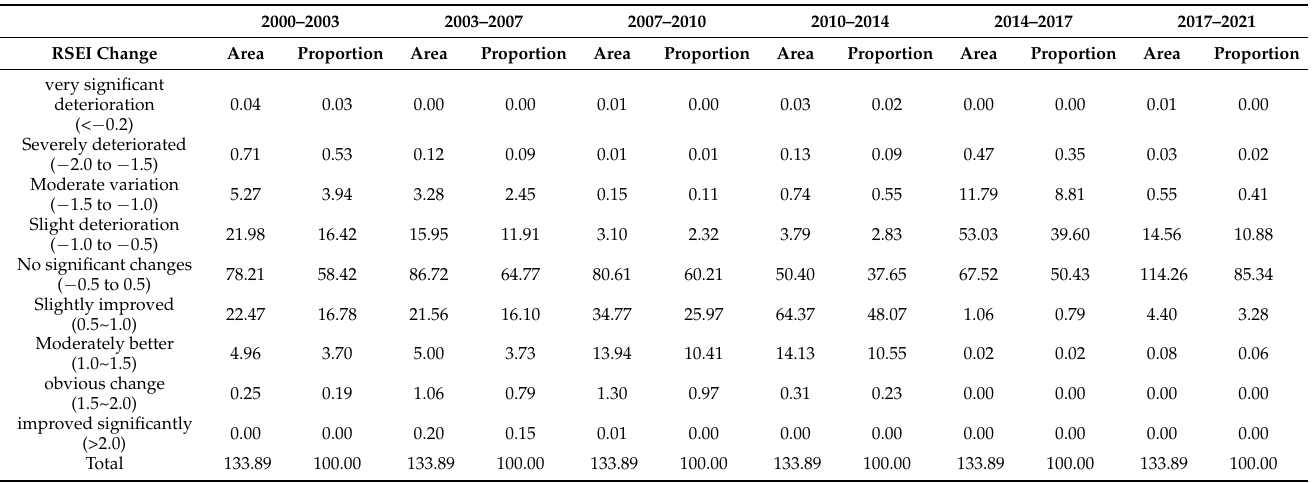
Table 6. Changes in the areas (10 3 km 2 ) and percentages (%) of the RSEI classes in the Weihe River Basin from 2000 to